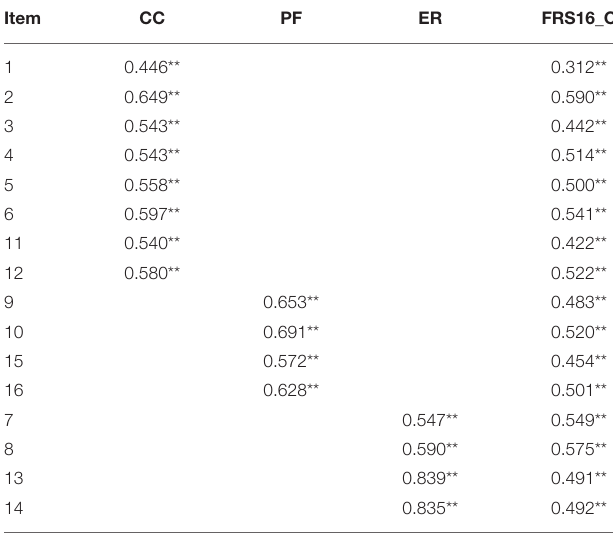
TABLE 8 | Item-to-scale and item-to-subscale